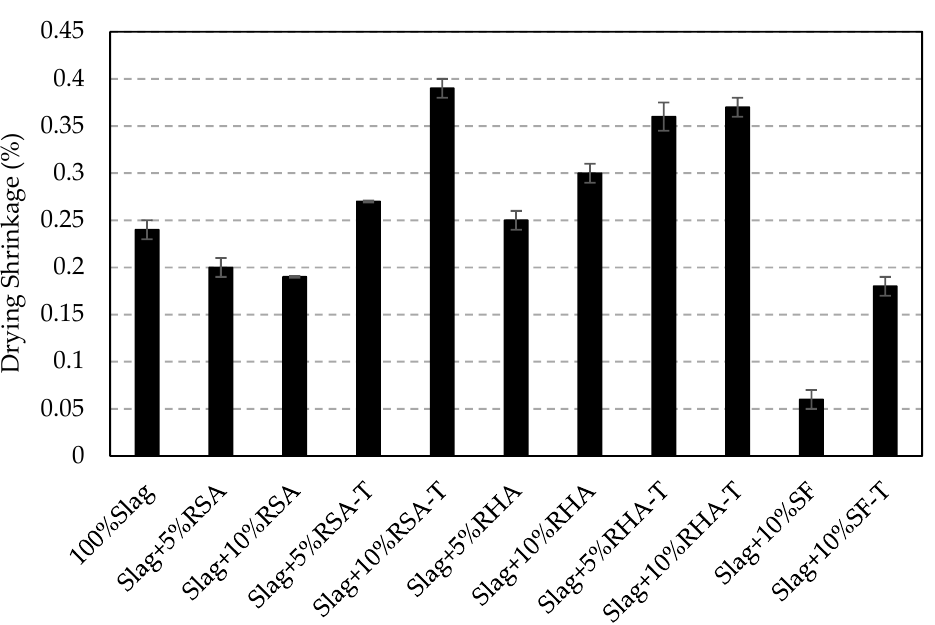
Figure 10. Drying shrinkage of AA mortar samples.